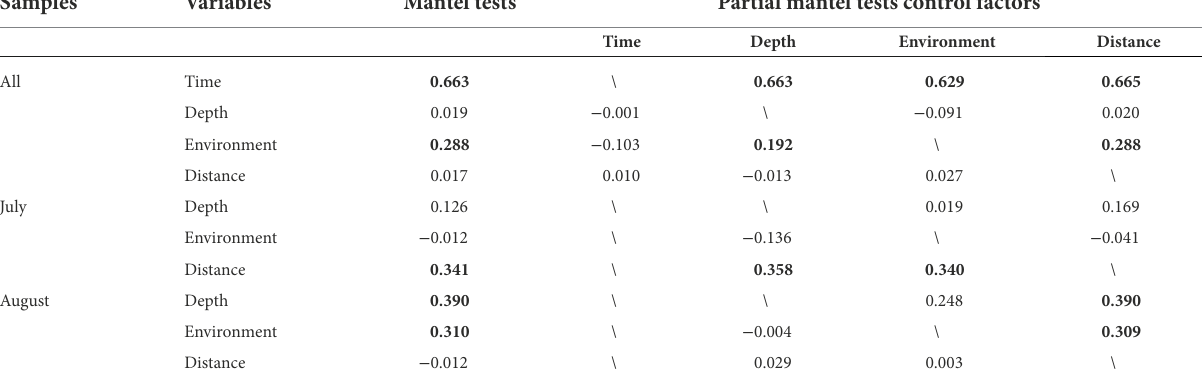
TABLE 2 Mantel and Partial Mantel tested Spearman correlations between geographic distance, collection depth, environment, and beta diversity. Samples